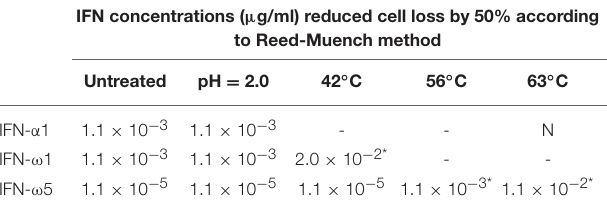
TABLE 1 | Higher acidic- and heat-stability of porcine IFN- ω subtype. IFN concentrations ( µ g/ml) reduced cell loss by 50% according to Reed-Muench